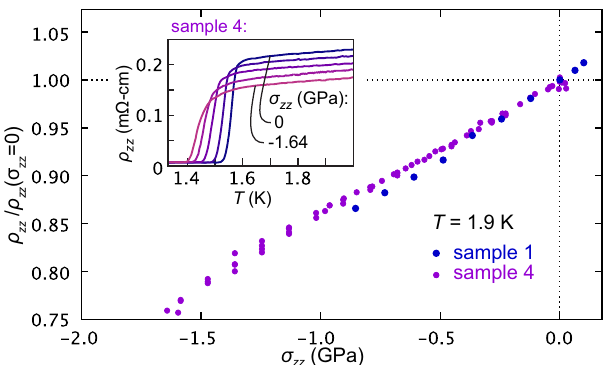
Fig. 2 | Electrical transport under c-axis stress. Main panel: c -axis resistivity ρ zz versusstress σ zz at1.9K,normalizedbyits σ zz =0value.Notethatthestressscaleof sample 1 is adjusted so that dT c / d σ zz as measured through the Meissner effect matches that from sample 4 over the range − 0.92< σ zz < − 0.2 GPa. At σ zz =0, Ω -cm,respectively.Inset: ρ ρ zz (1.9K)ofsamples1and4is0.278and0.228m zz versus temperature for sample 4 at 0, − 0.37, − 0.85, − 1.25, and −